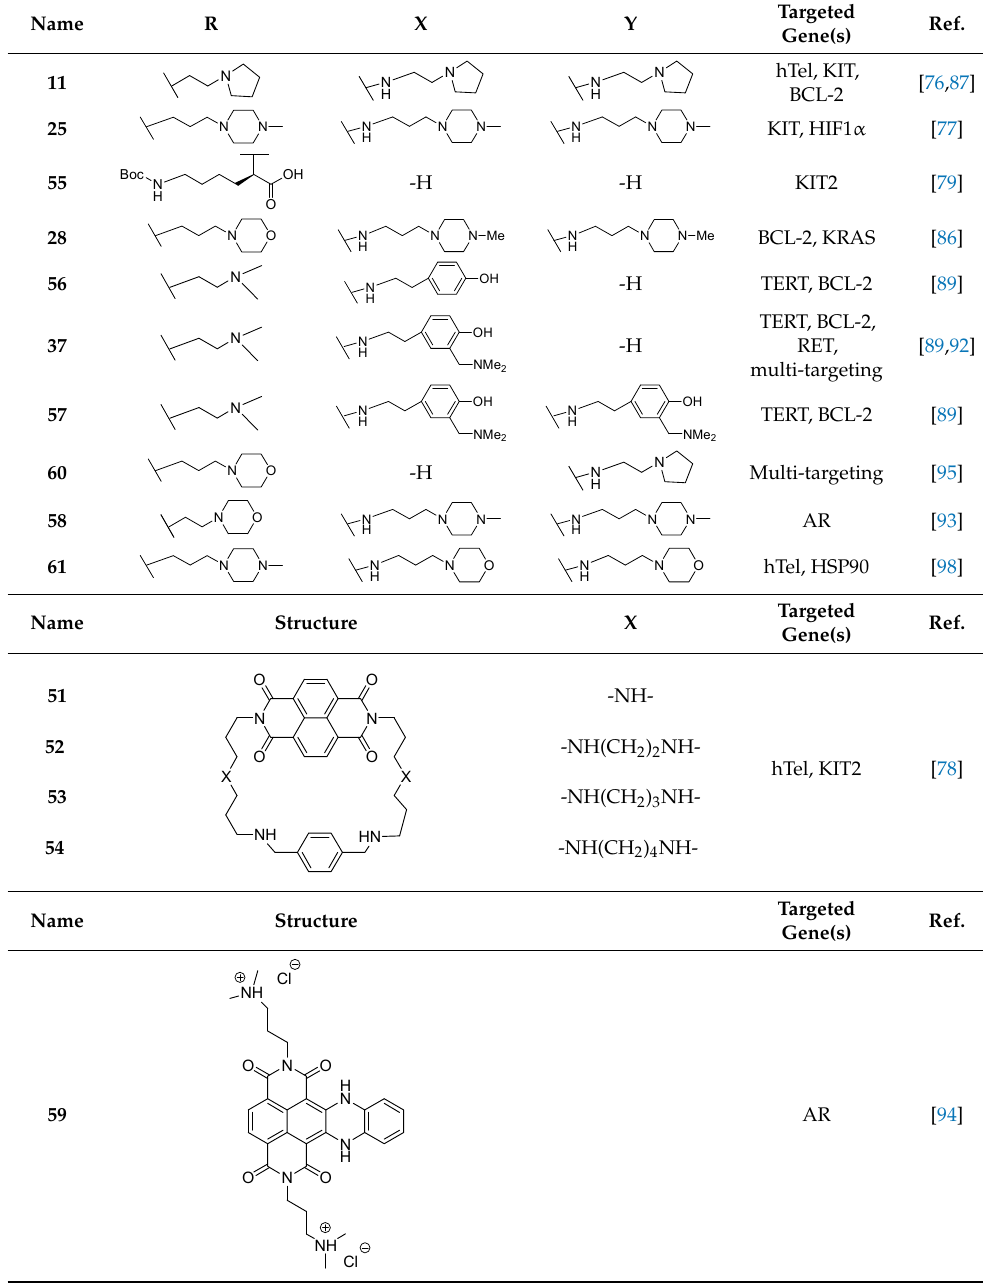
Table 3. Structures of NDIs used to target gene expression.